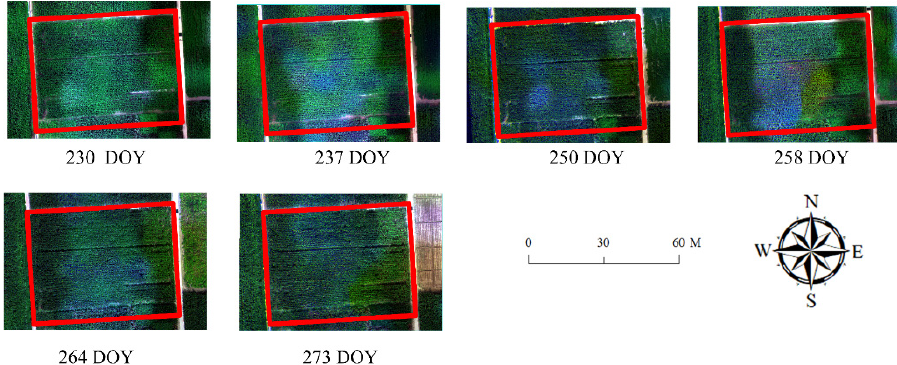
Figure A2. The multispectral images at different growth stages of maize. Table A1. The application of fertilizers in 20 plots. The number after NPK represents the actual multiple applications of fertilizers. The plots correspond to the plots shown in Figure 1. The 1, 2, and 3 each represent 0.7, 1.4, and 2.1 kg of the elements, respectively. Plots Combinations Grain Yield 1 Grain Yield